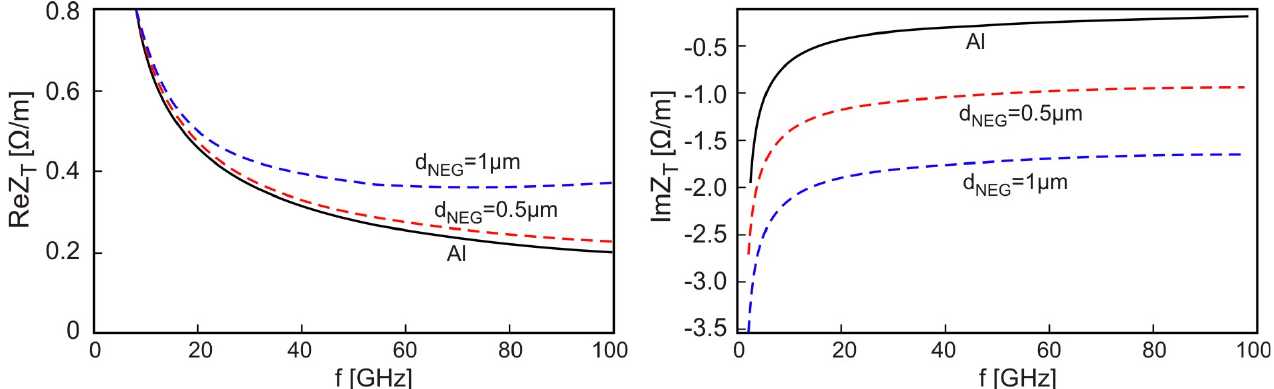
FIG. 4. (Color) Real (left) and imaginary (right) parts of the transverse dipole impedance for PETRA III wiggler vacuum chamber. Aluminum chamber with NEG coating.